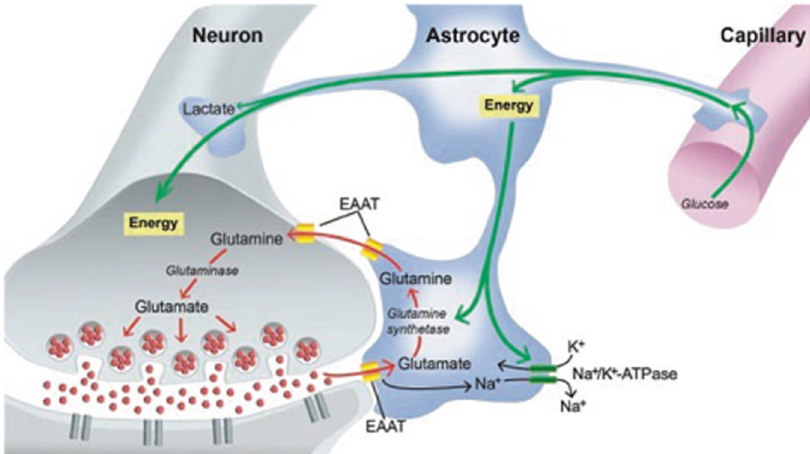
Fig. 1 Glutamate/glutamine cycle. Glutamate removed from synaptic cleft by excitatory amino acid transporters (EAATs) into astrocytes and converted into glutamine by enzyme glutamine synthetase. Glutamine is then transported out of astrocytes into nerve terminals and converted back to glutamate via glutaminase (reproduced from Magistretti PJ, Pellerin L, Rothman DL, et al. (1999). Energy on demand. Science 283: 496 – 497 permission from The American Association for the Advancement of Science